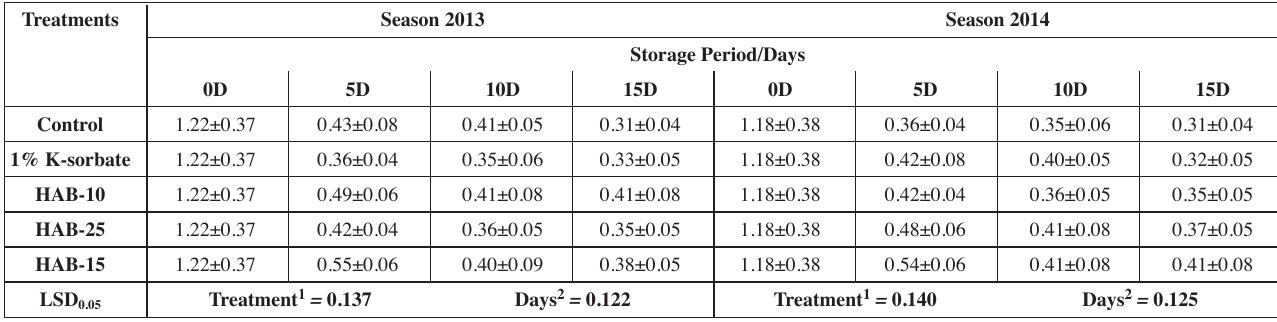
Tab. 6: Effect of fluorescent Pseudomonas species on pH of tomato stored at 23±4 ºC with relative humidity in the range of 25% - 70%. Treatments